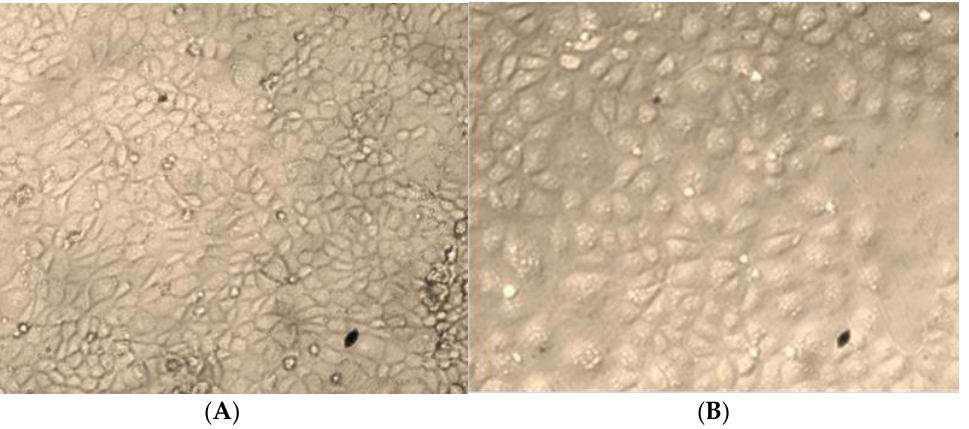
Figure 6. Images depicting the morphological changes in ( A ) untreated control cells and ( B ) HepG2 cells treated with okra extract at IC 50 concentration at 20X magnification under phase-contrast microscopy.